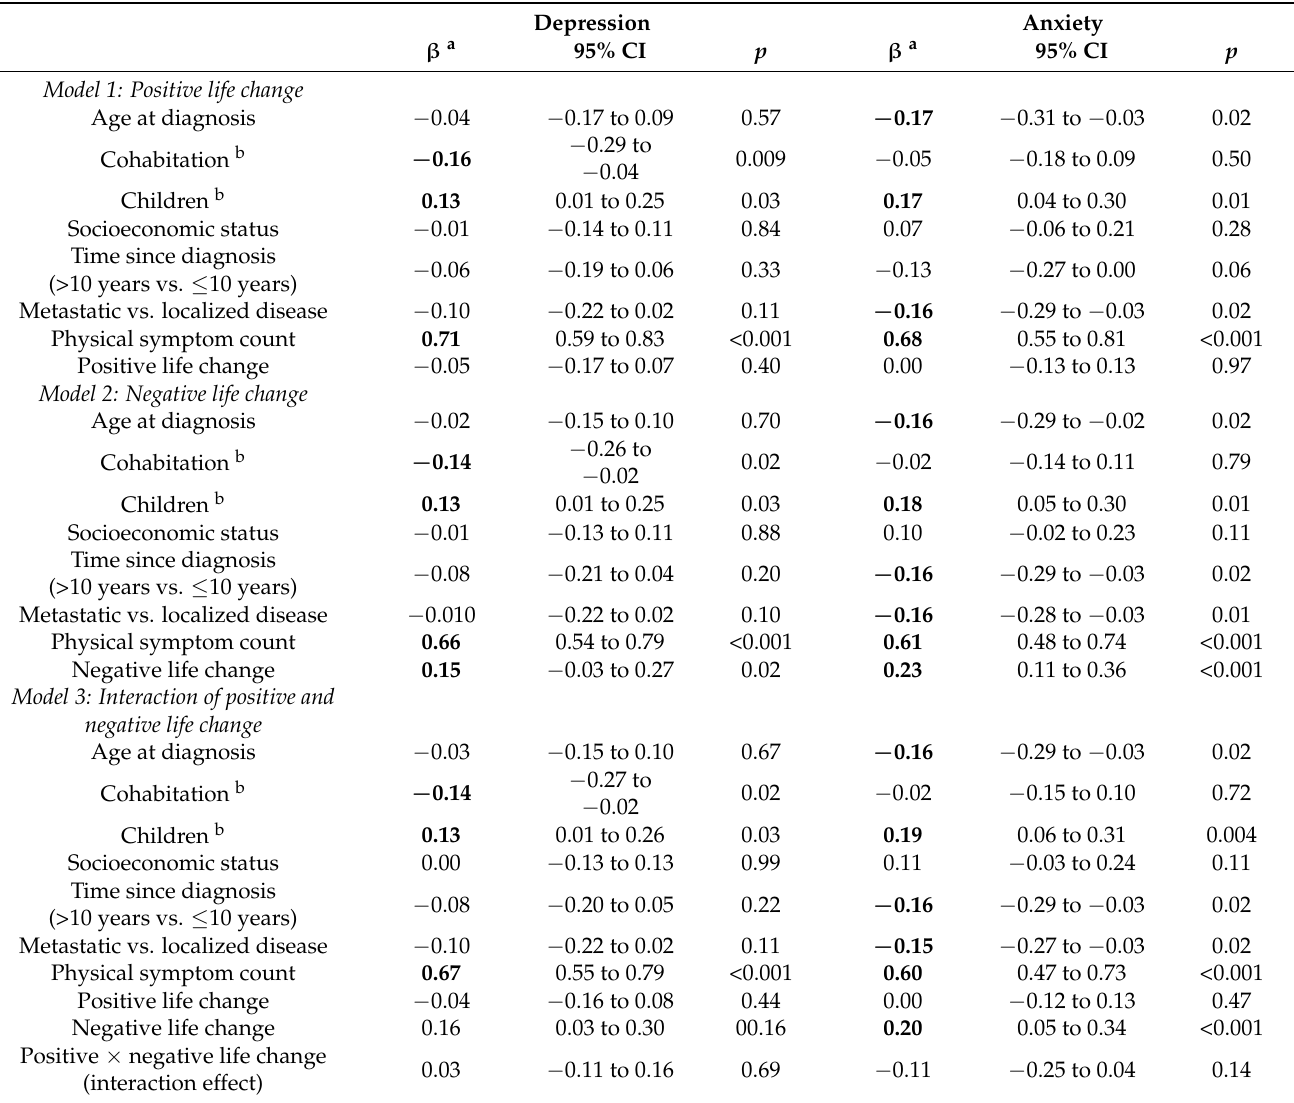
Table 7. Impact of positive and negative change on depression and anxiety ( N = 164). Depression